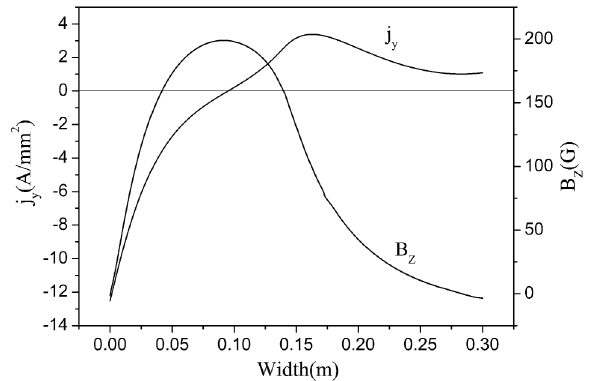
FIG. 11. The Y component of the eddy current density, j the SS plate and the field due to the eddy current at z ¼ 10 mm are plotted for 50 Hz frequency when the plate is exposed to a nonuniform time varying magnetic